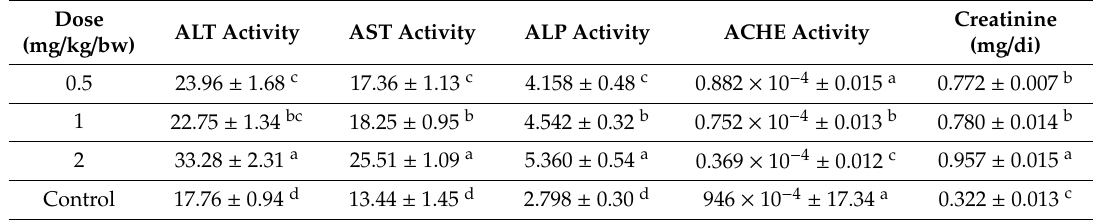
Table 1. E ff ect of cymoxanil at di ff erent concentration levels on some biochemical parameters in